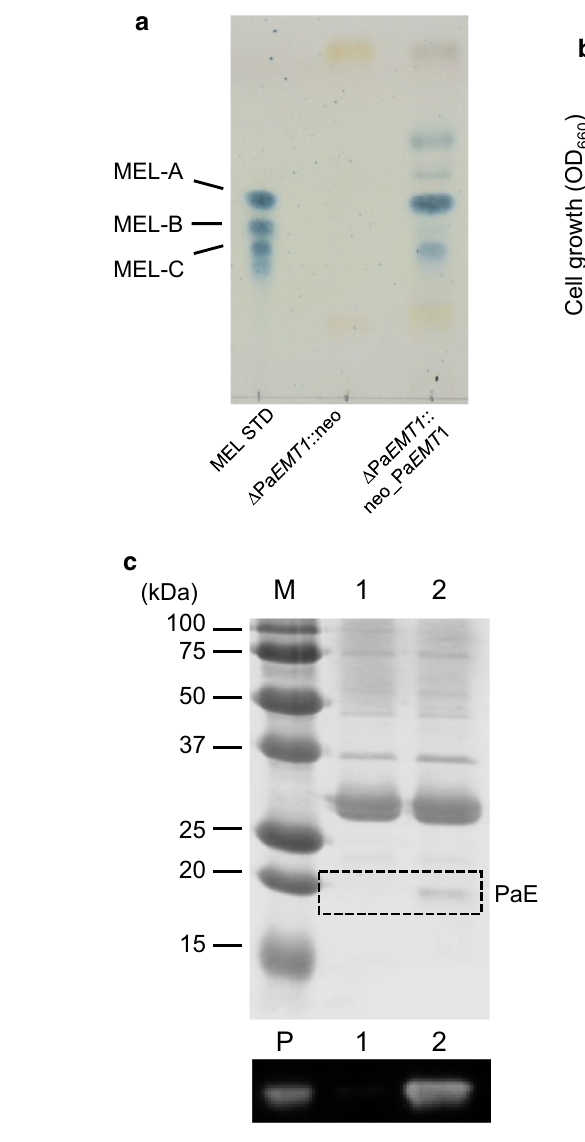
Fig. 3 PaE production by strain ∆Pa EMT1 harboring Pa EMT1 in 3 FMM medium supplemented with 8% xylose. a TLC analysis of MEL production by × the Pa EMT1 -complemented strain. ∆Pa EMT1 ::neo: ∆Pa EMT1 strain harboring pUXV1_neo, ∆P aEMT1 ::neo_Pa EMT1 : ∆Pa EMT1 strain harboring pUXV1_ neo-PaEMT1. b Cell growth (white) and PaE activity (gray). c SDS-PAGE and PaE detection through western blot analysis of culture supernatant. M, marker; P, purified PaE; Lane 1, ∆PaEMT1::neo; Lane 2, ∆Pa EMT1 ::Pa EMT1 . The amount of each culture supernatant loaded in the gel was 10 μL for